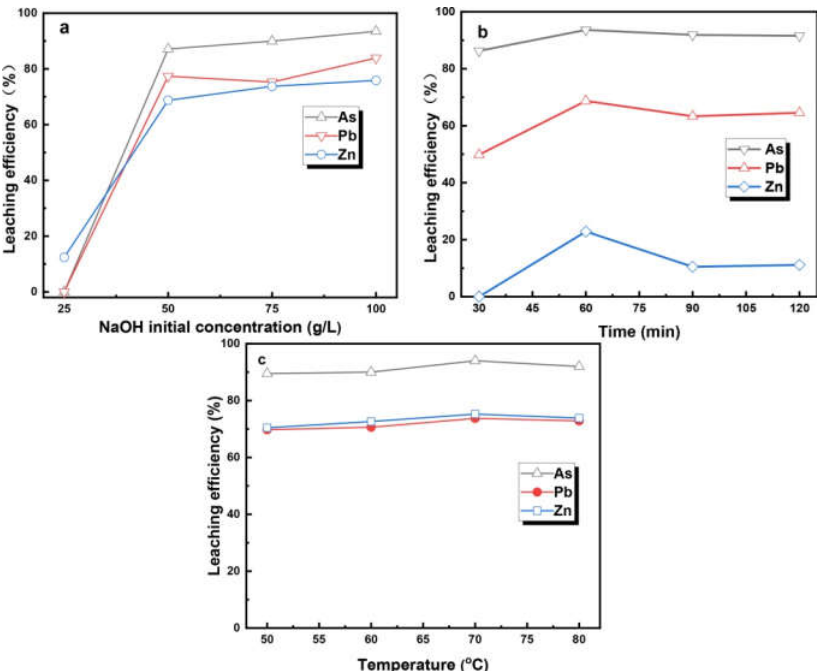
Figure 4. (a) Effect of NaOH concentration on the leaching efficiencies (70 °C, 10:1 mL/g and 90 min), (b) experimental reaction duration (70 °C, 10:1 mL/g and 75 g/L) and (c) reaction temperature (75 g/L, 10:1 mL/g and 90 min).